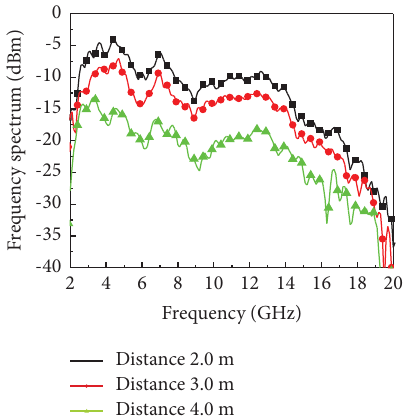
Figure 6: Spectral amplitude of calibration sphere echo.